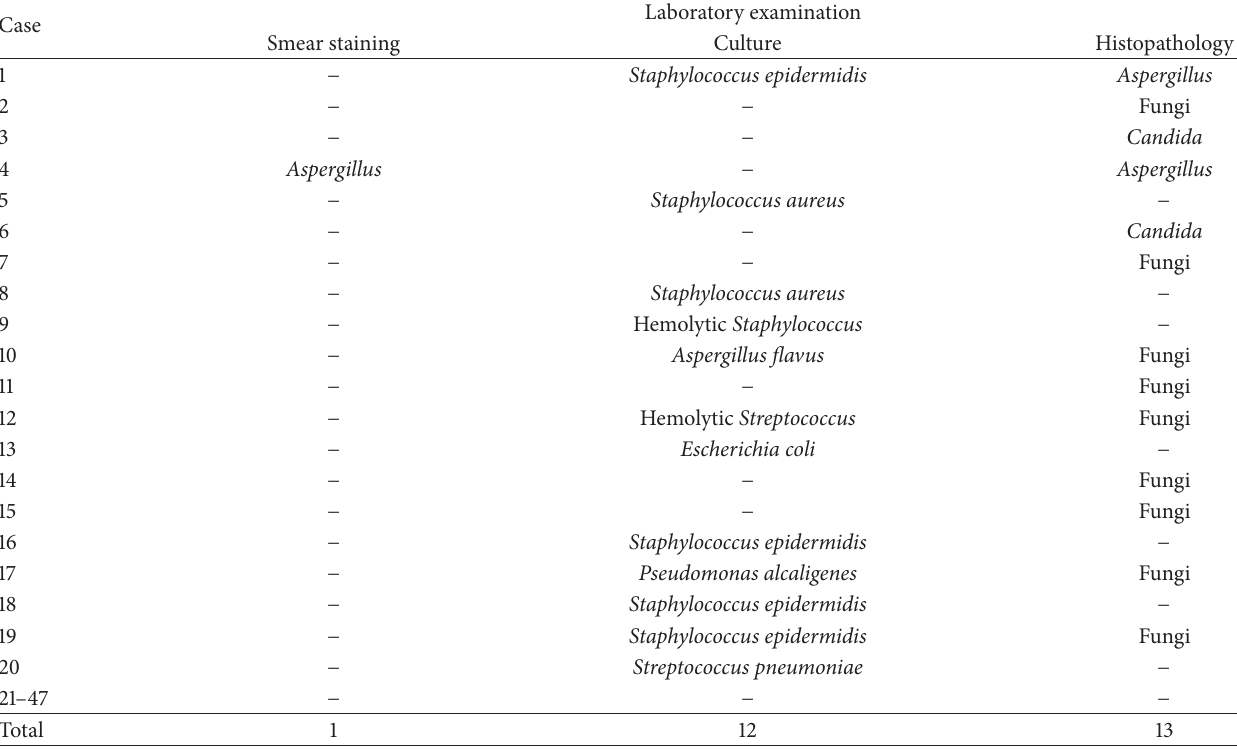
Table 1: Results of pathogen examination from 47 clinically presumed fungal keratitis subjects.